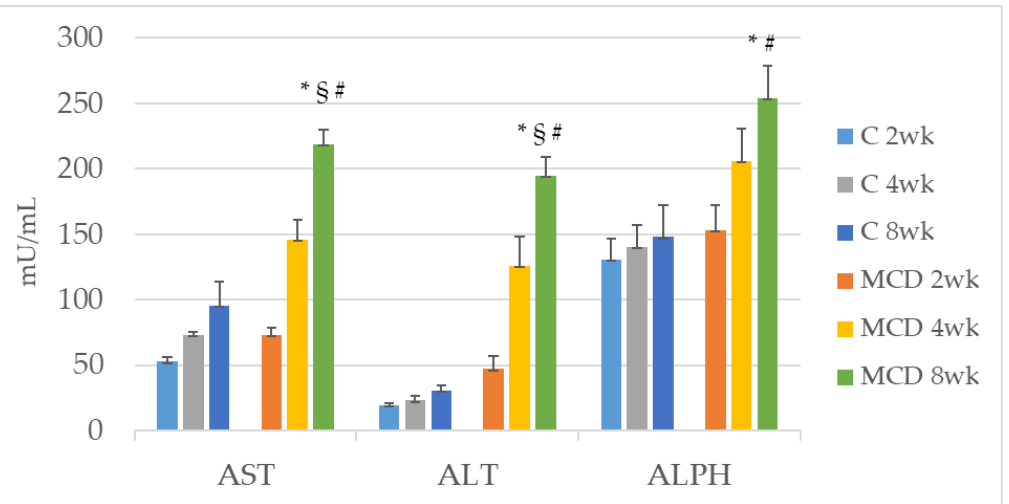
Figure 1. Time-course of changes in serum enzymes (AST, ALT and ALPH) using rats fed with MCD diet for 2-, 4- and 8 weeks. * p ≤ 0 .05 versus MCD 2 wk; § p ≤ 0 .05 versus MCD 4 wk; # p ≤ 0 .05 versus respective control. AST, ALT and ALPH: mU/mL; weeks (wk).